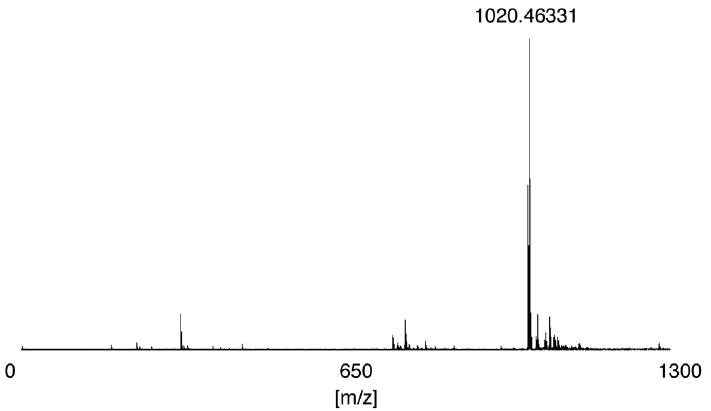
Figure 7. Mass spectrum of flavin-CKLVFF ( 1 ) obtained in negative-ion